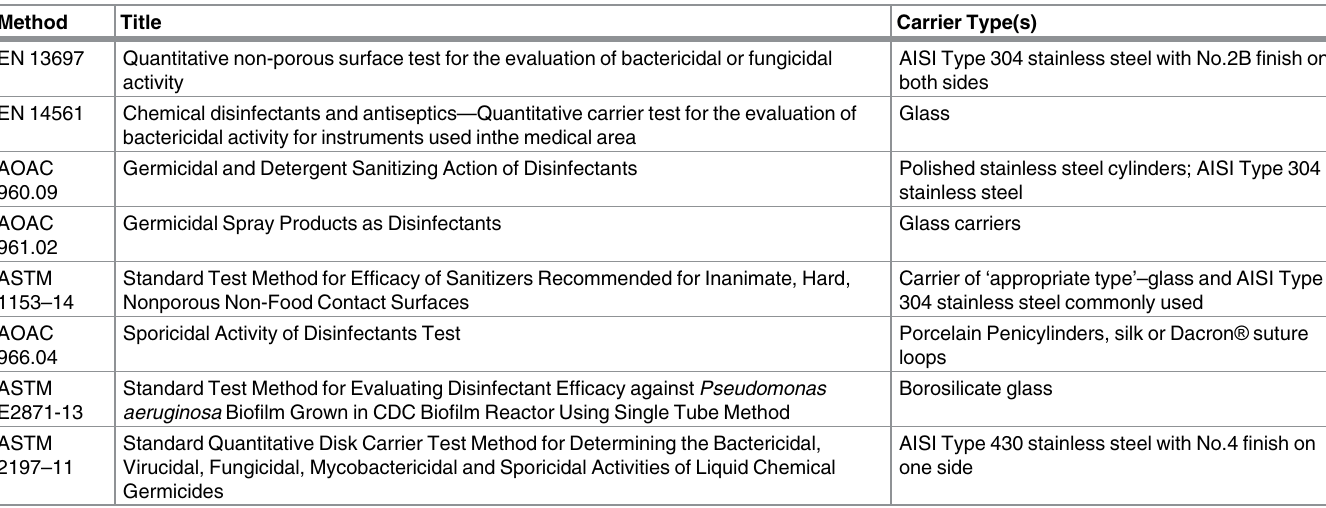
Table 1. Standard antimicrobial test methods and carrier